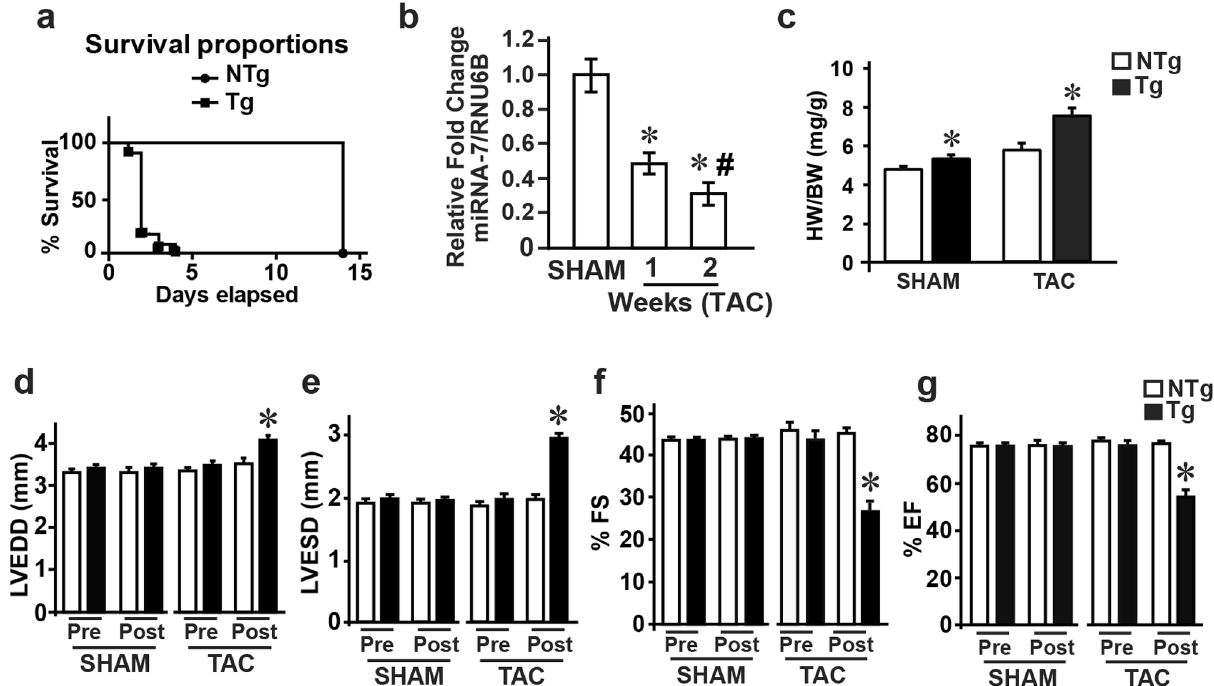
Figure 3. Cardiomyocyte expression of miRNA-7 exacerbates cardiac dysfunction and failure following pressure overload by transverse aortic constriction (TAC) ( a ), Kaplan–Meier survival curves for 12 months old NTg and Tg mice subjected to TAC (n = 8). ( b ), Real time PCR analysis for miRNA-7 expression from cardiac tissue of NTg mice following Sham, 1 or 2 weeks of TAC. * p < 0.001 vs. SHAM; # p < 0.01 vs. 1 week TAC (n = 8). ( c ), Heart weight to body weight (HW/BW) ratio of NTg and Tg following two weeks of TAC in 3 months old mice (n = 11).* p < 0.05 vs. SHAM. ( d–g ) Cardiac functional parameters of NTg and Tg mice measured by echocardiography following 2 weeks of TAC (n = 11); LVEDD (left ventricular end-diastolic dimension) ( d ), LVESD (left ventricular end-systolic dimension) ( e ), percent fractional shortening (%FS) ( f ), percent ejection fraction (%EF) ( g ). * p < 0.005 vs. Sham (NTg or Tg) and pre-TAC (NTg or Tg) (n = 11).